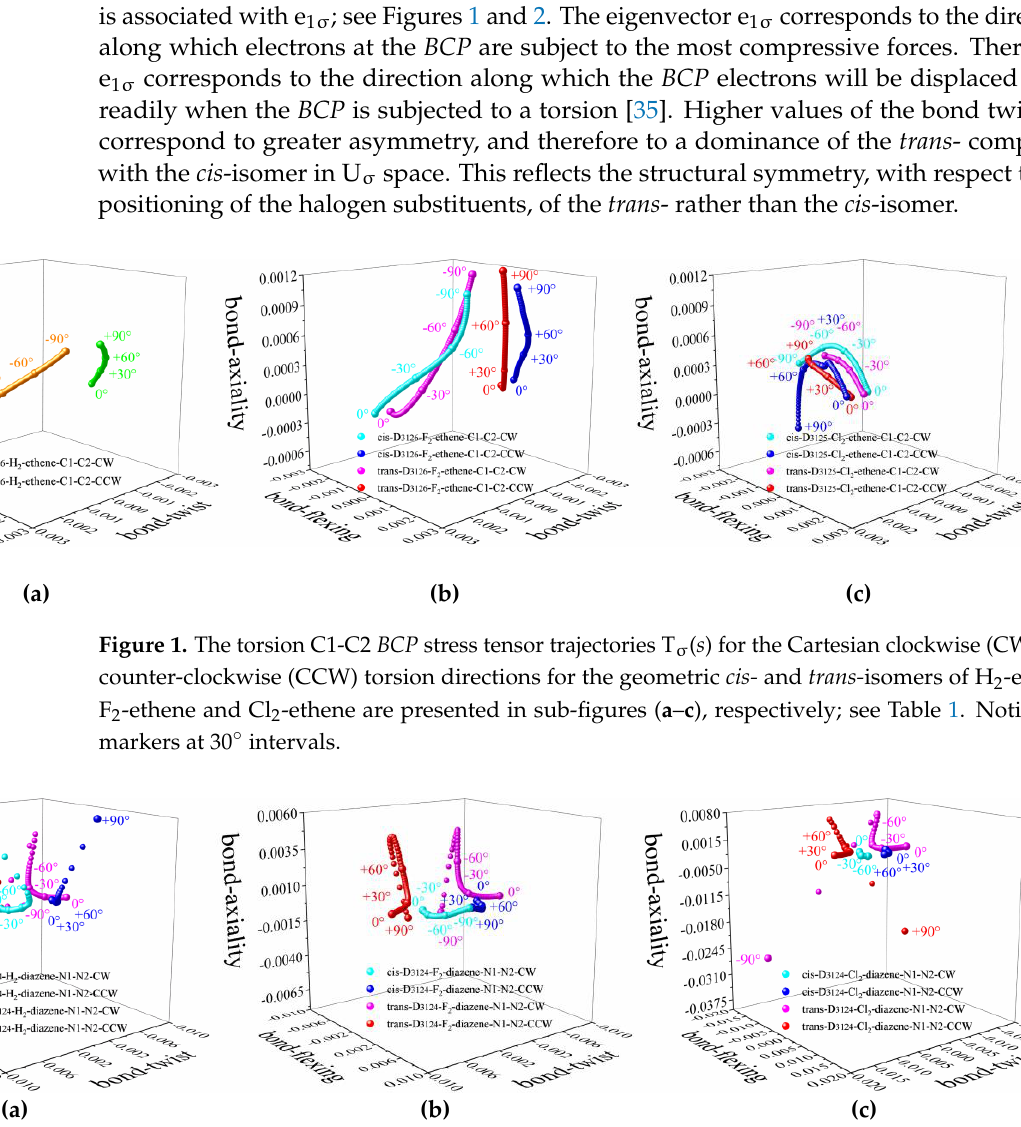
Figure 2. The N1-N2 BCP stress tensor trajectories T σ ( s ) for the Cartesian CW and CCW torsions for the cis- and trans- isomers of H 2 - diazene, F 2 -diazene and Cl 2 -diazene are presented in sub-figures (a-c), respectively; see the caption of Figure 1 and Table 2. Table 2. The U σ -space bond cross-section sets {T σ ,F σ } of the C1-C2 BCP for the doubly substituted diazene torsion.